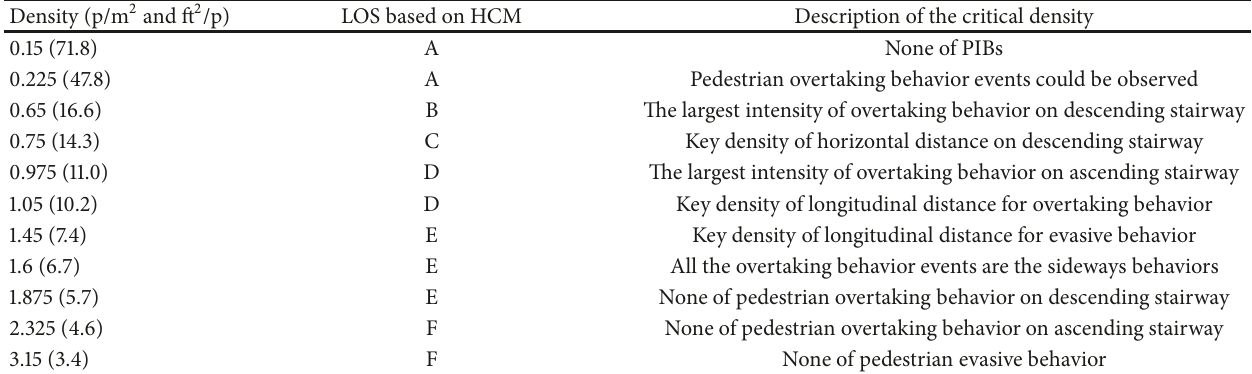
Table 5: Critical densities observed in this study.